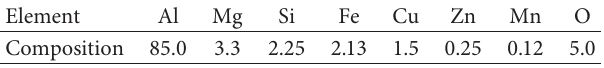
Table 1: Chemical composition of AA6061 (wt. %).